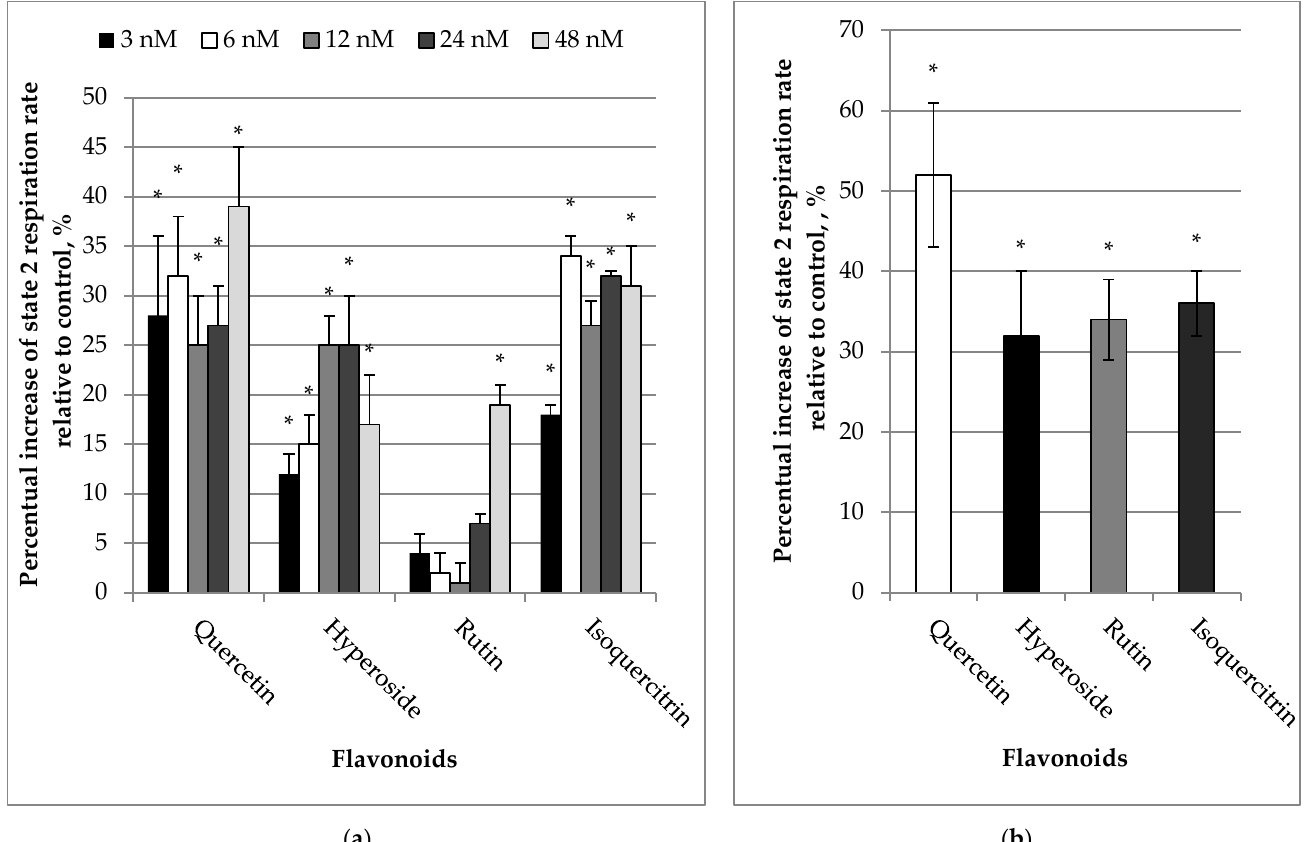
Figure 1. ( a ) Effect of flavonoids (3–48 nM) on State 2 respiration rates in kidney mitochondria. ( b ) Effect of flavonoids (10 µM) on State 2 respiration rate in kidney mitochondria. The mitochondrial State 2 respiration (V 2 ) rate was recorded in medium supplemented with mitochondria and substrates (5 mM glutamate + 5 mM malate). The respiration rate of mitochondria without added flavonoids was considered as a control. The effect was calculated according to Formula (1). * Statistically significant difference ( p < 0.05) compared to control (State 2 respiration rate without flavonoids). A significant part of proton leak is dependent on the adenine nucleotide trans-locator (ANT), the most abundant carrier protein in the mitochondrial inner membrane, and to a smaller extent on uncoupling protein (UCP). Therefore, we tested which of these pathways may be activated by quercetin. Carboxyatractyloside (CAT), an inhibitor of the adenine nucleotide translocator, statistically significantly ( p < 0.05) reduced (by 76%) quercetin- stimulated State 2 respiration rate (Figure 2b). Further addition of guanosine